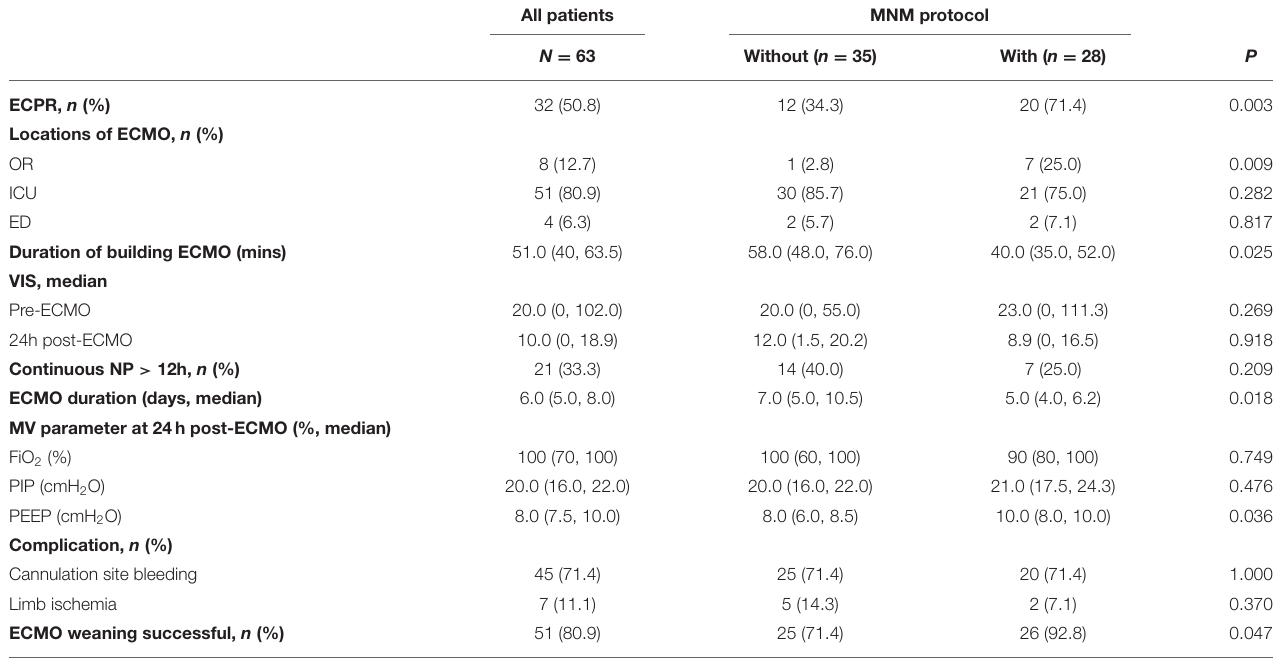
TABLE 4 | Comparison of VA-ECMO related characteristics.